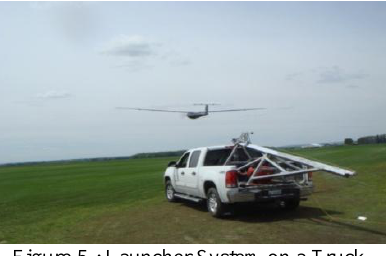
Figure 5 : Launcher System on a